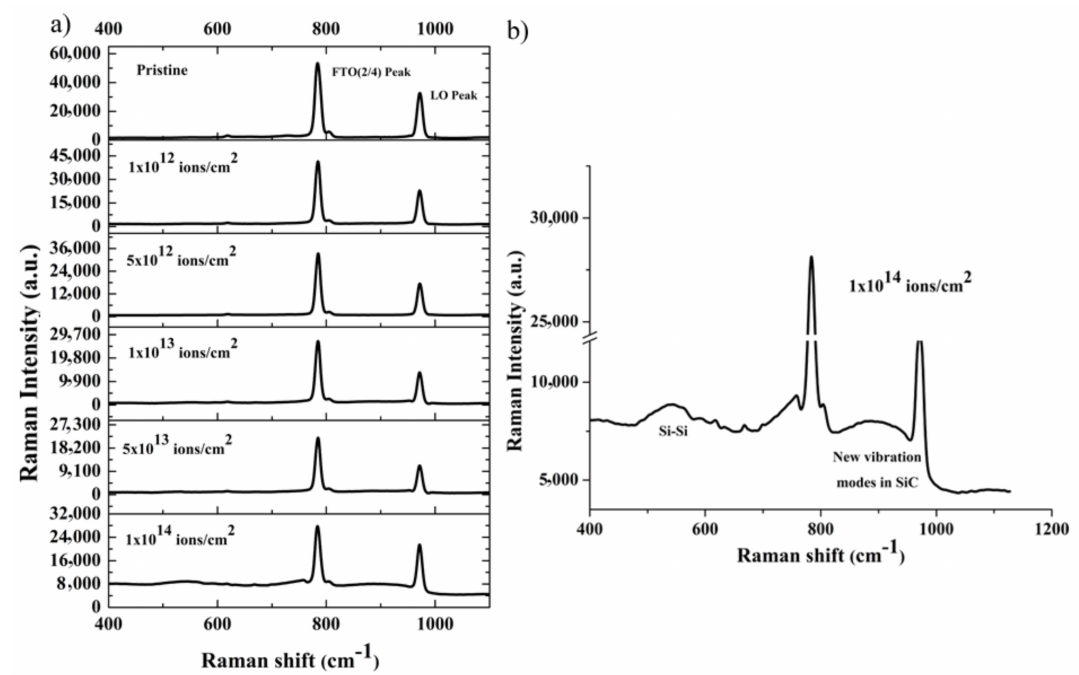
Figure 3. (a) Raman spectra showing changes in the prominent SiC peaks at varying fluences in N +